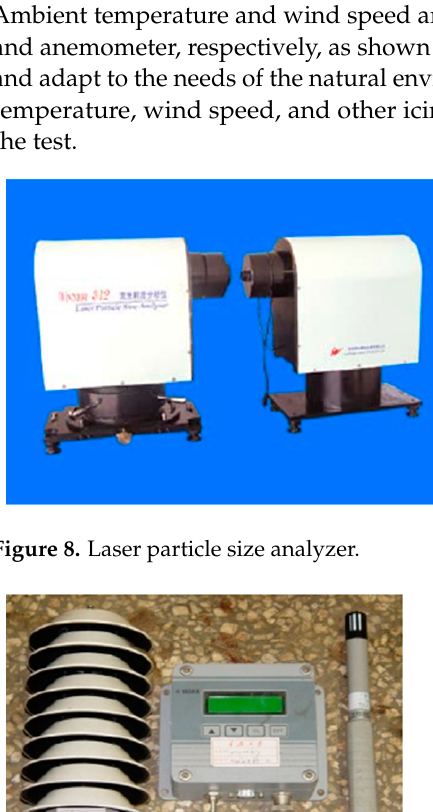
Figure 10. Anemometer. 4.2. Test Method As shown in Figure 11, ice will grow on the four cylinders, and the icing environment parameters will transport to the computer via wireless. At the same time, these parameters will be gathered by other equipment as mentioned above. During the experiment, the ic- ing environment parameters were controlled randomly by the artificial climate chamber.